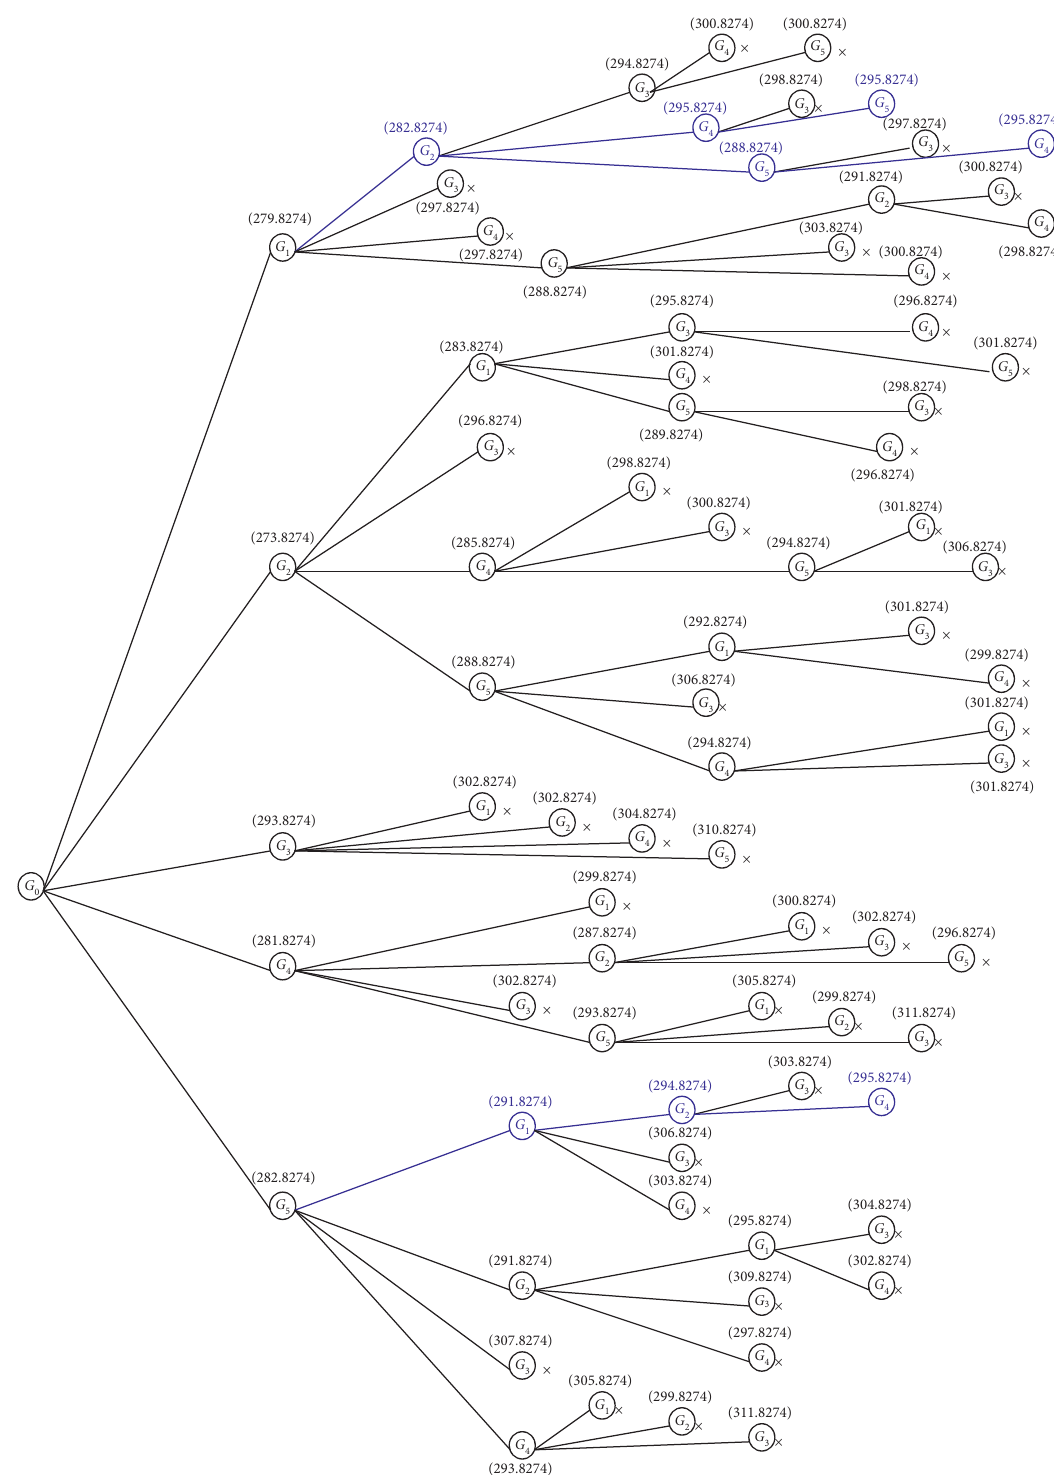
Figure 1: Search tree of the B&B algorithm for the example ( × denotes